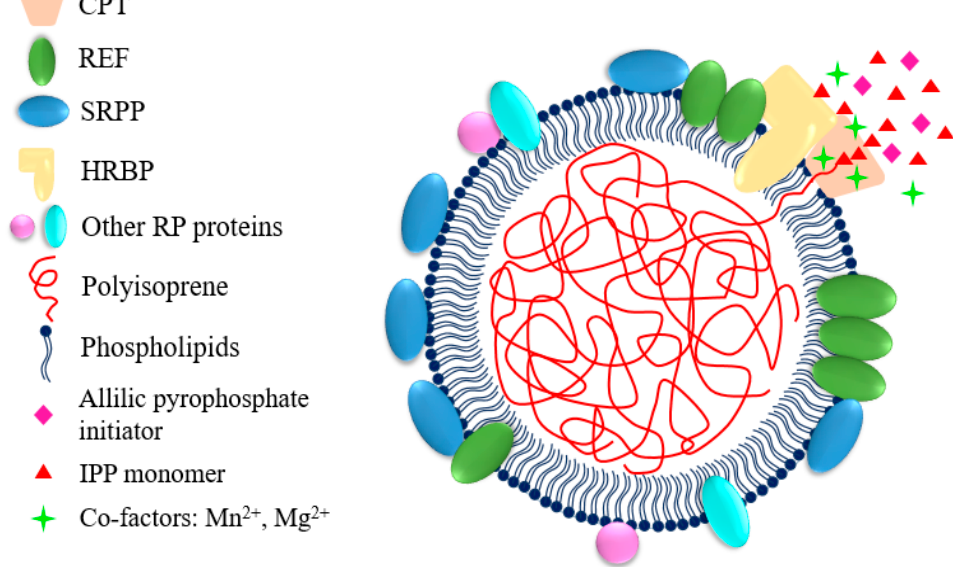
Figure 4. Schematic model of rubber particles. Rubber particles are made of polyisoprene, surrounded by a monolayer of lipids with proteins and other compounds. The synthesized polyisoprene chains are elongated inward and stored in the interior of the rubber particles. The H. brasiliensis rubber biosynthetic machinery is supposed to consist of HRT1, HRBP and REF. HRBP may work as a scaffold tethering HRT1 on the surface of rubber particles. REF may function in stabilizing the rubber biosynthetic machinery, while both REF and SRPP may play roles in rubber particle stabilization and coagulation. REF contains one predicted transmembrane domain and may be inserted deeply into the rubber particle lipidic monolayer, while SRPP has no predicted transmembrane domain and may just associate with the lipidic monolayer. CPT, cis -prenyltransferase; HRT1, Hevea rubber transferase 1; HRBP, HRT1-REF bridging protein; REF, rubber elongation factor; SRPP, small rubber particle protein; RP, rubber